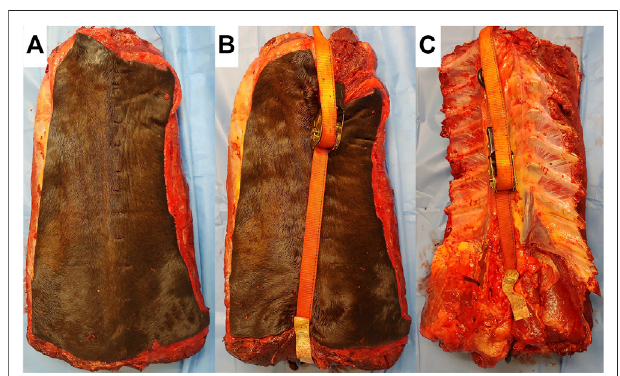
FIGURE 1 | Images of spine sections prior to CT scanning. (A) Resting phase. (B) Flexion, ratchet strap calibrated to 2000N is placed on the dorsal aspect, compressing the dorsal spinous processes together. (C) Extension, ratchetstrap isplacedintheventralaspectofthesection,separatingthe dorsal spinous processes, and placing the interspinous ligament under